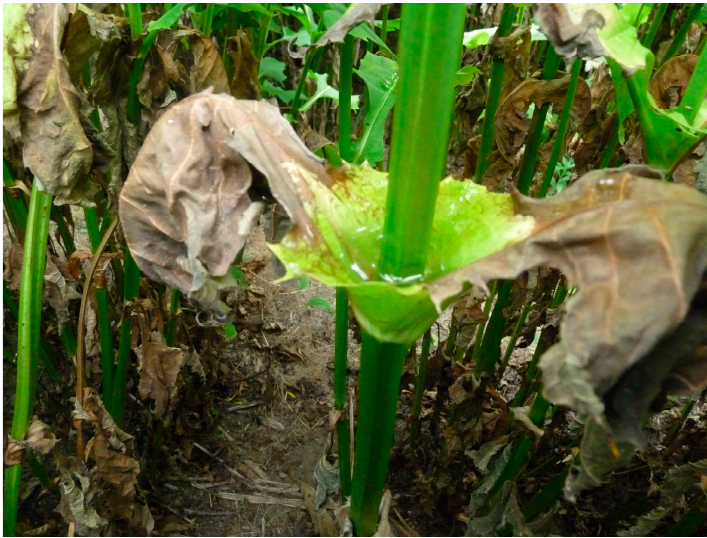
Figure 4. Inside of rows of Silphium plots (seeds) in the third vegetation season.